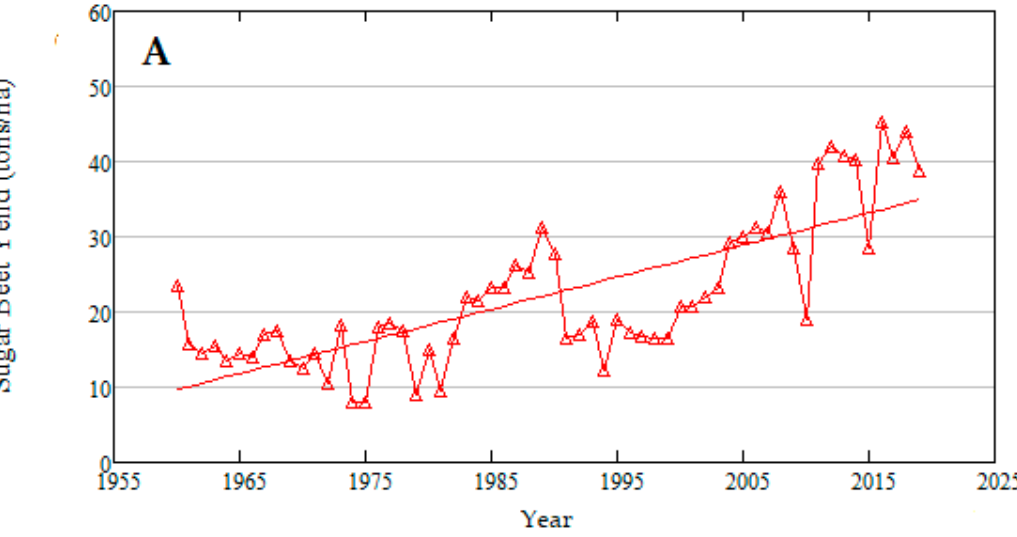
Figure 5. Sugar beet yield (tons ha − 1 ) over the ( a ) northern, ( b ) central and western, and ( c ) southeastern districts within the Belgorod Region (see Figure 4). The solid line is the regression line for each (tons ha − 1